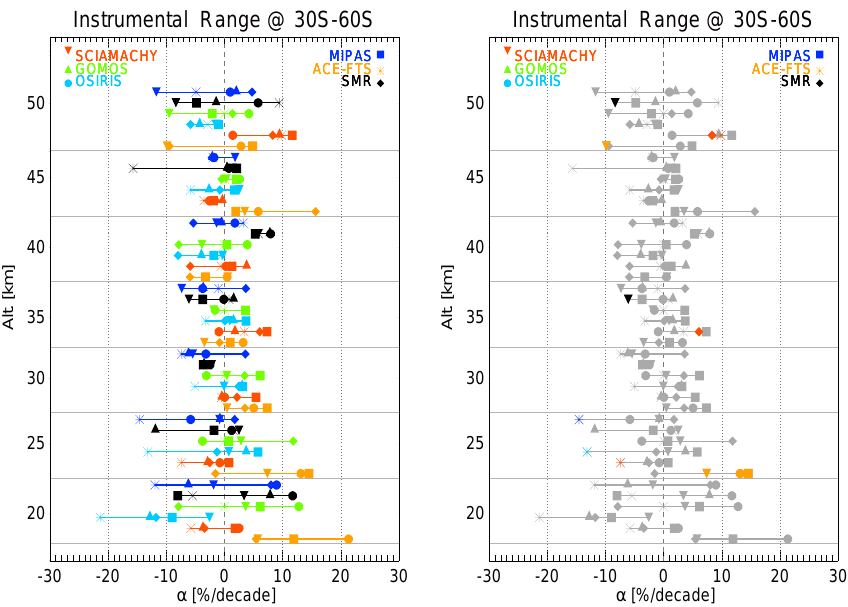
Figure 9. Same as Fig. 7 but for the southern middle latitudes (30–60 ◦